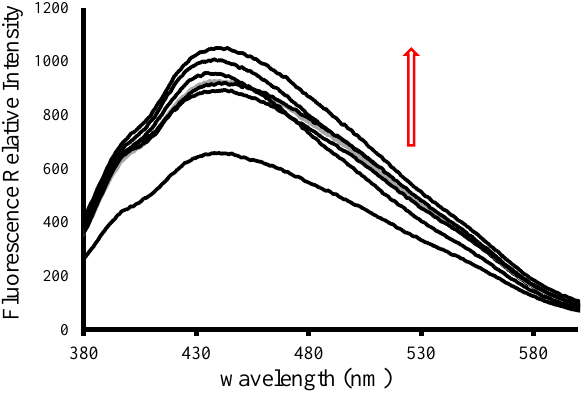
Figure 3. An enhancement in the fluorescence of 5a upon increasing the concentration of ct-DNA.